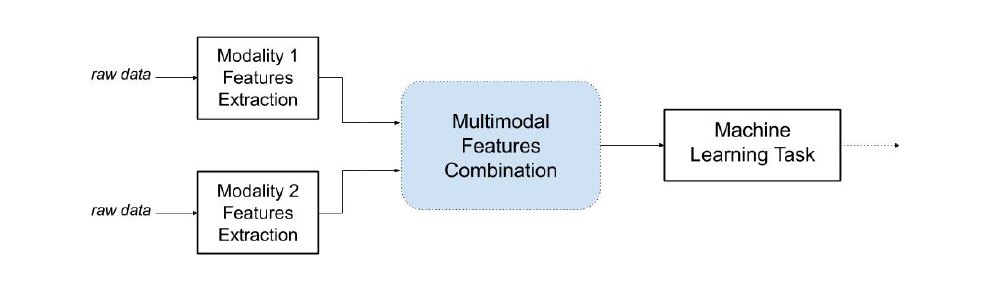
Figure 8. General scheme for early fusion. The outputs of unimodal analyses are fused before a concept is learned.